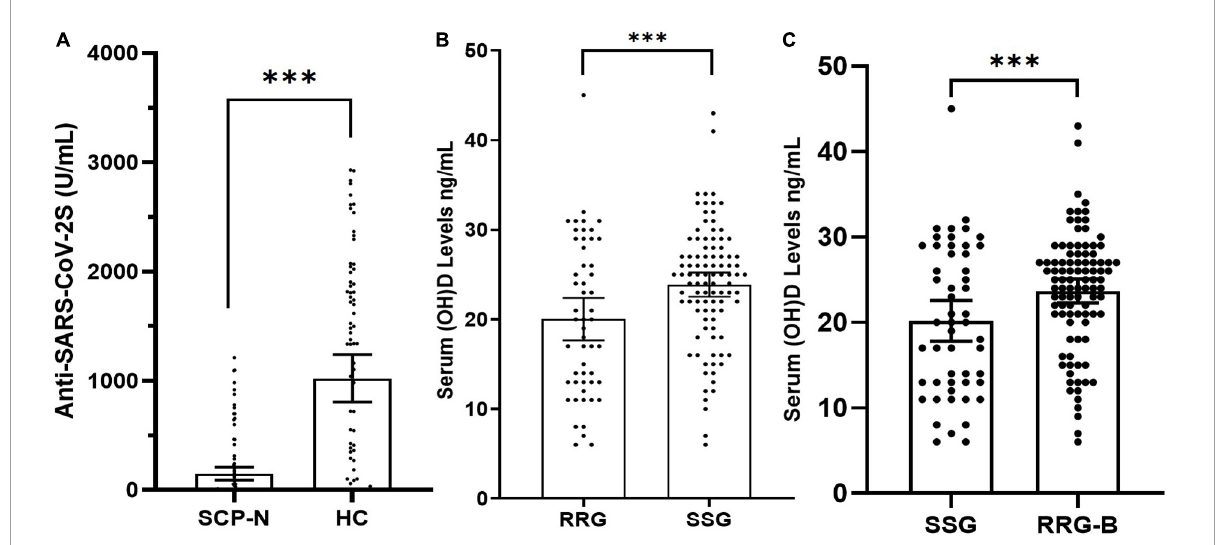
FIGURE1 (A) Dot plot of anti-SARS CoV-2S serology titers after the third dose of COVID-19 vaccines in solid cancer patients (SCP) and healthy control (HC) participants with standard-dose vaccine negativity. (B) Matched dot plot of vitamin D levels in the serial seronegative group (SSG) and the robust response group (RRG). (C) Matched dot plot of vitamin D levels in the serial seronegative group (SSG) and the robust response group-booster (RRG-B). The symbol “***” denotes